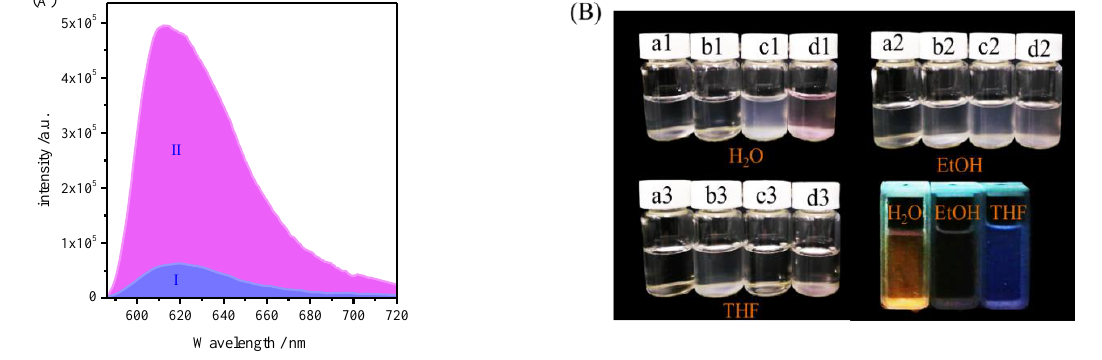
Figure 8. ( A ) The fluorescence spectrum of I SNPs- g -PS- b -PHMEA- co -PHMEA-RhB, II PHMEA- co -PHMEA-RhB formed in solution. ( B ) The dispersibility of SNPs (a1, a2, a3), SNPs-Br (b1, b2, b3), SNPs- g -PS (c1, c2, c3), SNPs- g -PS- b -PHMEA- co -PHMEA-RhB (d1, d2, d3) with concentration 0.33 mg / mL in H 2 O, EtOH, THF solutions, respectively, and the UV-irradiation picture of SNPs- g -PS- b -PHMEA- co -PHMEA-RhB in H 2 O(1), EtOH(2), THF(3) three di ff erence solutions at 365